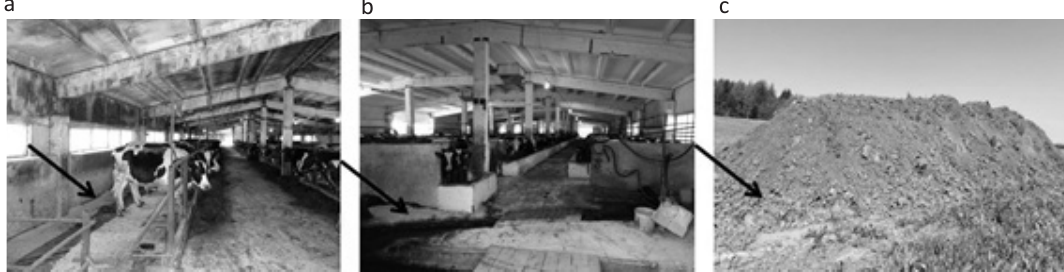
Fig. 1. Sampling places (a = cattle excrement, ex-animal ; b = ex-housing manure, c = organic fertiliser ready for use, ex-storage)